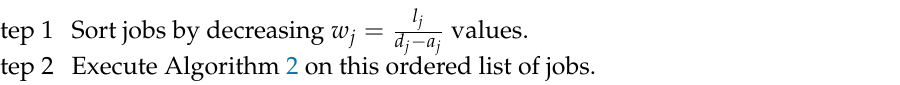
Algorithm 3 MinFit-Offline